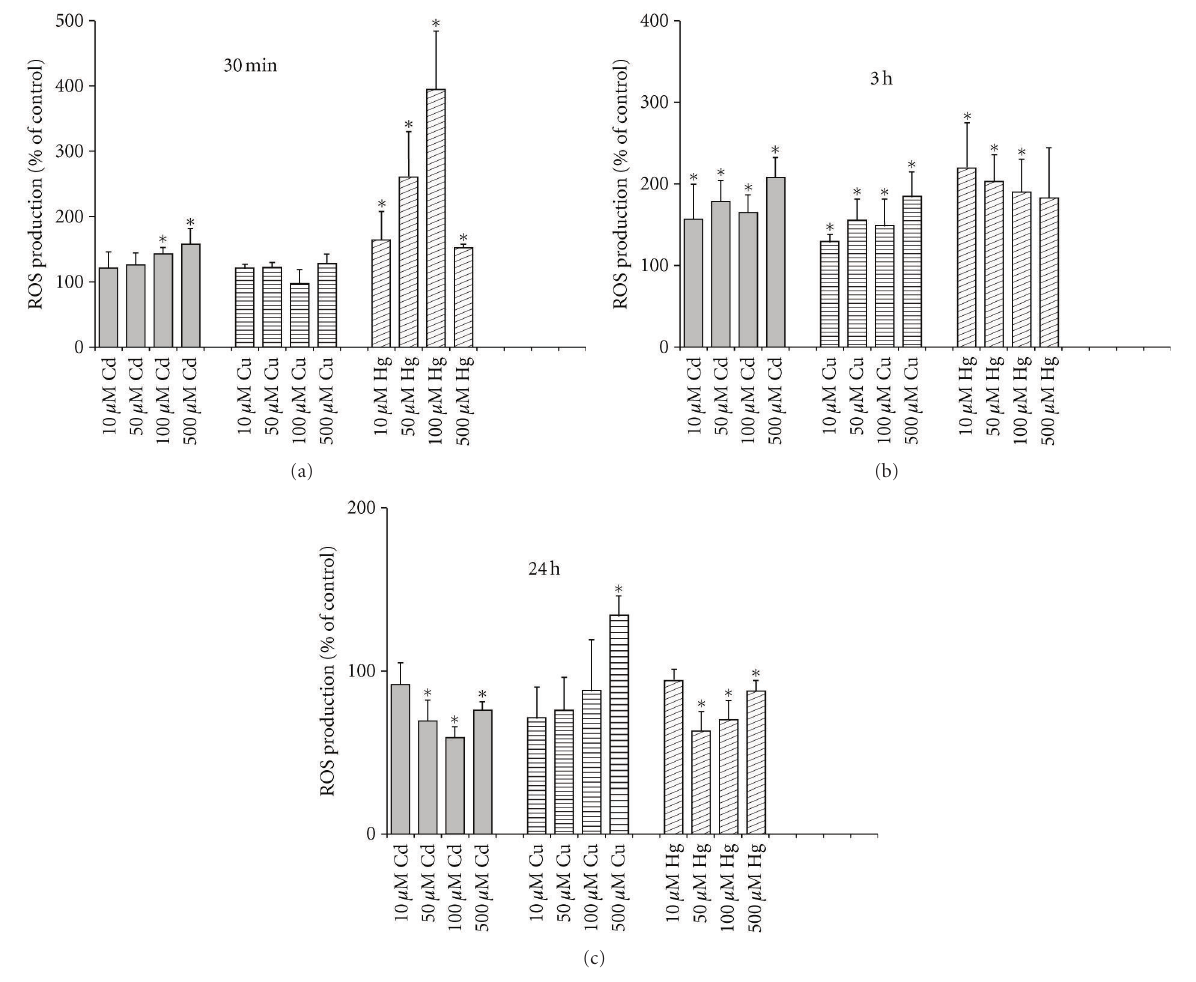
Figure 2: Time- and dose-dependent e ff ects of Cd 2+ , Cu 2+ , and Hg 2+ on ROS formation by PC12 cells measured spectrofluorometrically using DCFH 2 -DA as the ROS-sensitive probe. The results are expressed in % to corresponding control ( ∗ P < 0 . 05 compared to untreated control; n = 3–7 independent experiments).